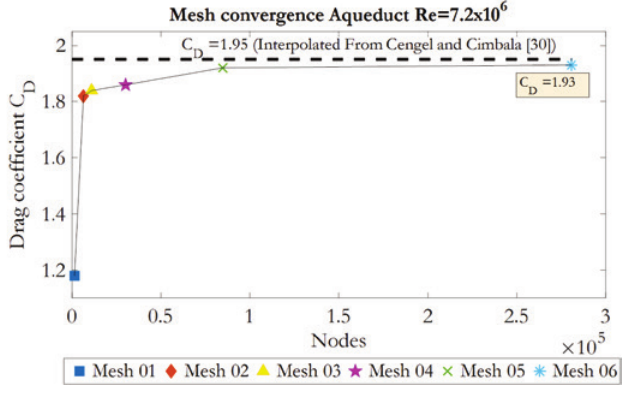
Figure 13 Mesh convergence — average drag — Model